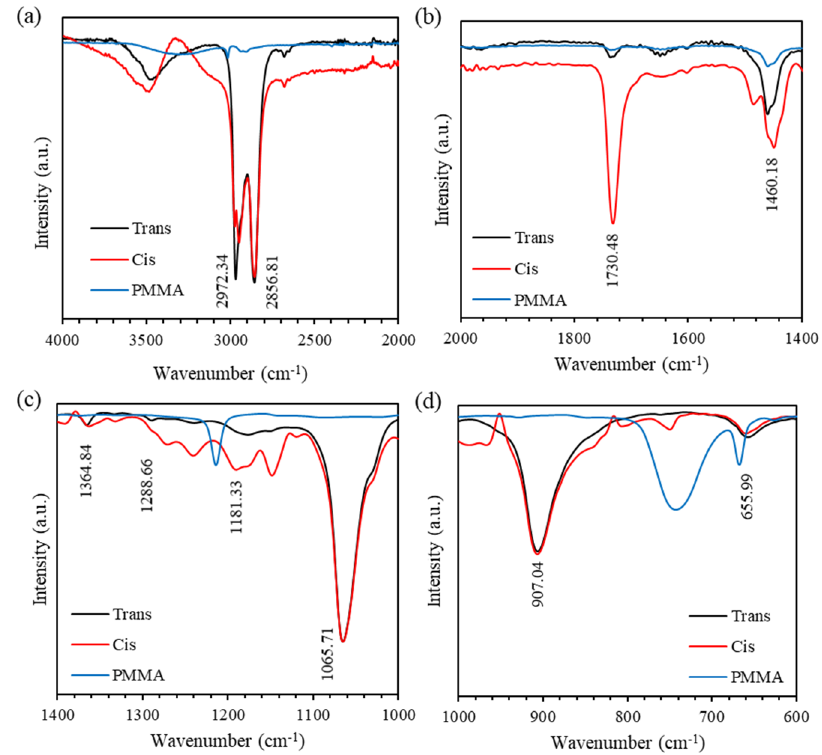
Figure 12. The FTIR spectra of trans- and cis- states of PMMA-BDK-MR polymer composite thin film: ( a ) 2000–4000 cm −1 , ( b ) 1400–2000 cm −1 , ( c ) 1000–1400 cm −1 , and ( d ) 600–1000 cm −1 .